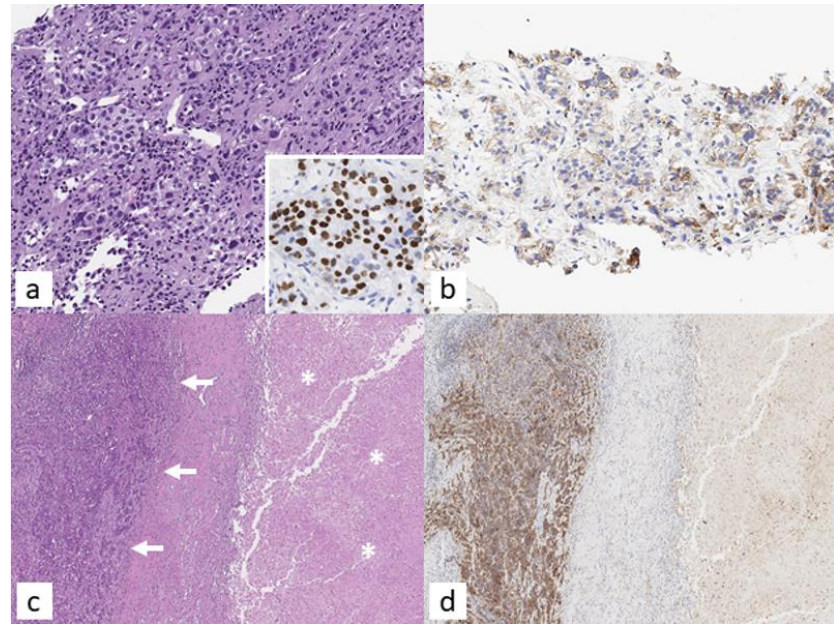
Figure 2. A representative panel depicting a case of squamous cell carcinoma (SCC) of the lung, diagnosed on core biopsy (( a ), H/E, 200×) and confirmed by p40 positivity (( a ), inset. 400×), featuring an inhomogeneous PD-L1 reactivity (( b ), PD-L1, 22C3 clone, Dako, 200× ) consistent with TPS ≥ 1% (>50%). On resection (( c ), H/E, 40×) after neoadjuvant therapy, the tumour specimen features the presence of a minor yet vital SCC component (arrows) alongside extensive necrotic areas; the former is characterized by intense and homogenous PD-L1 expression (( d ), PD-L1, 22C3 clone, Dako, 40×).